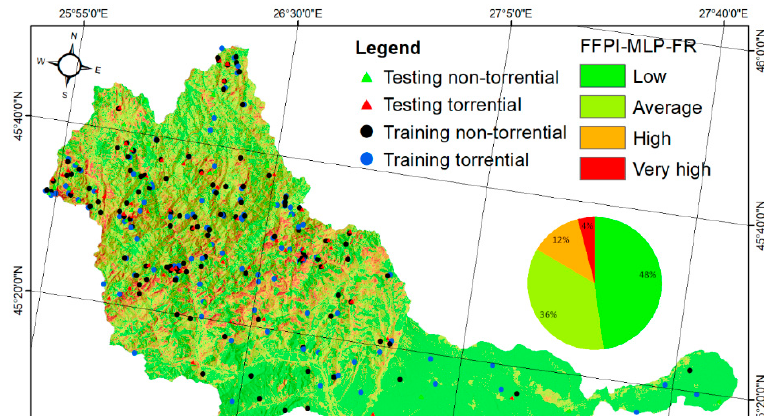
Figure 13. Flood and flash ‐ flood hazard map. 4.4. Flood and Flash ‐ Flood Model Performance Evaluation with ROC Curves The performance evaluation of a model using the ROC (receiver operating characteristic) curve is a widely used method in research. The ROC curve represents a 2D plot which indicates the performance of a classifying system as the value of the discrimination cut ‐ off is changed with respect to the predictor variable. The AUC (area under the curve) model represents a way to evaluate the testing ability in order to discriminate the true values. The ROC and AUC curves are made up from the sensitivity and specificity axes [79]. The success rate (Figure 14a,b) shows that the MLP–FR hybrid model was the best ‐ performing model for both indices, with a value of 0.986 for the FPI and 0.952 for the FFPI, whilst the prediction rate (Figure 14c,d) shows the same trend. For both indices, the frequency ratio model proved to be the worst ‐ performing model in terms of the success and prediction rate.